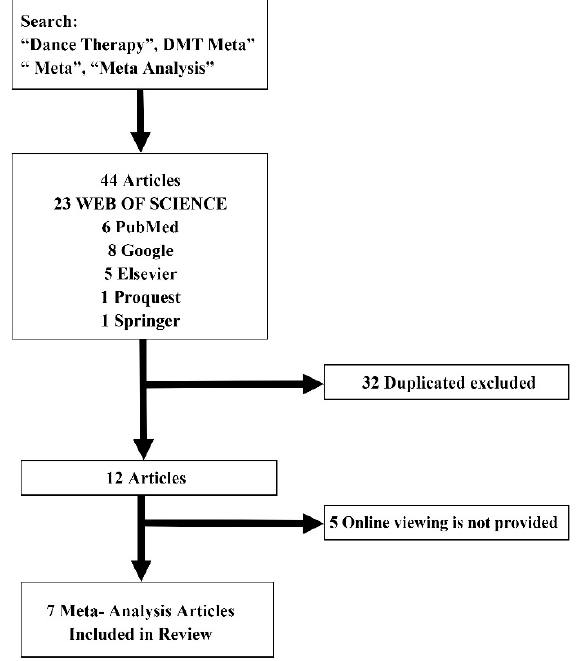
Figure 1. Meta ‐ analysis related to dance therapy selection process of individual research products. Figure 1. Meta-analysis related to dance therapy selection process of individual research